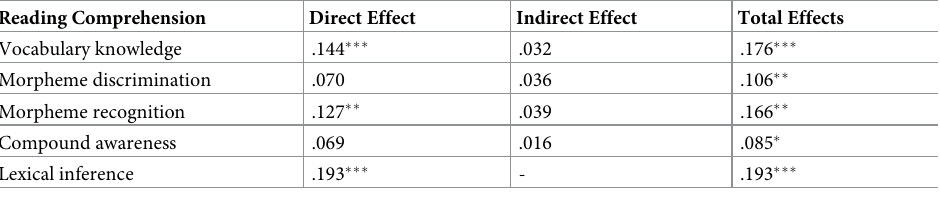
Table 5. Standardized total effects, direct effect, and indirect effect on reading comprehension. Reading